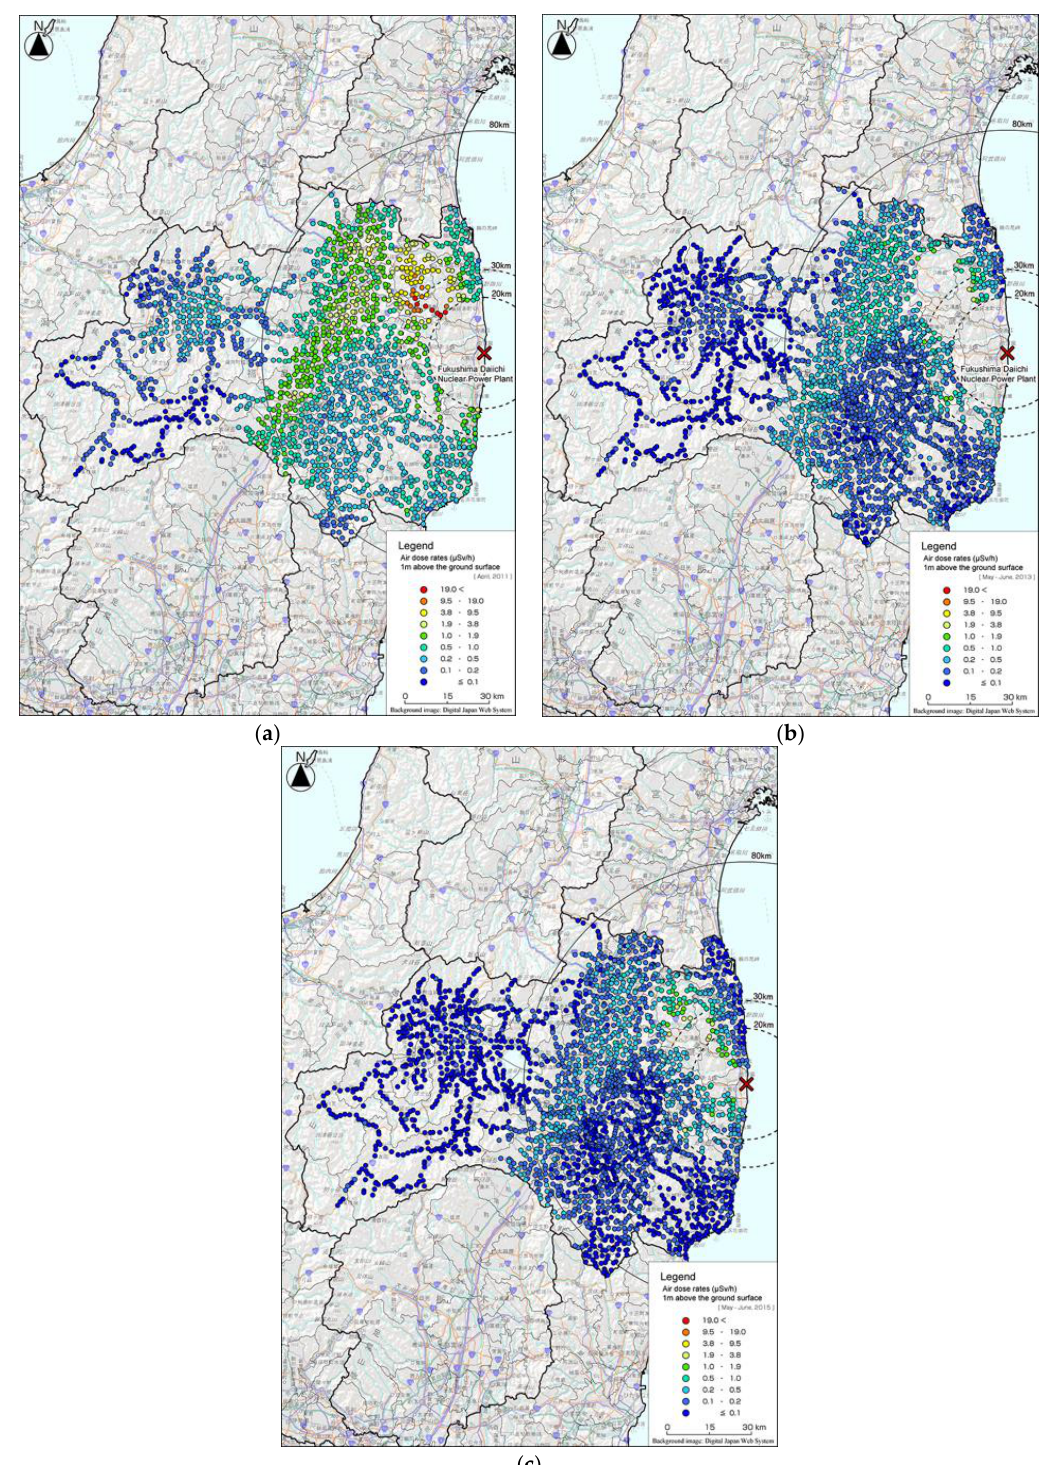
Figure 2. Local dose rates measured in Sv/h ( a ) on 29 April 2011 and ( b ) on 18 November 2016 [61].